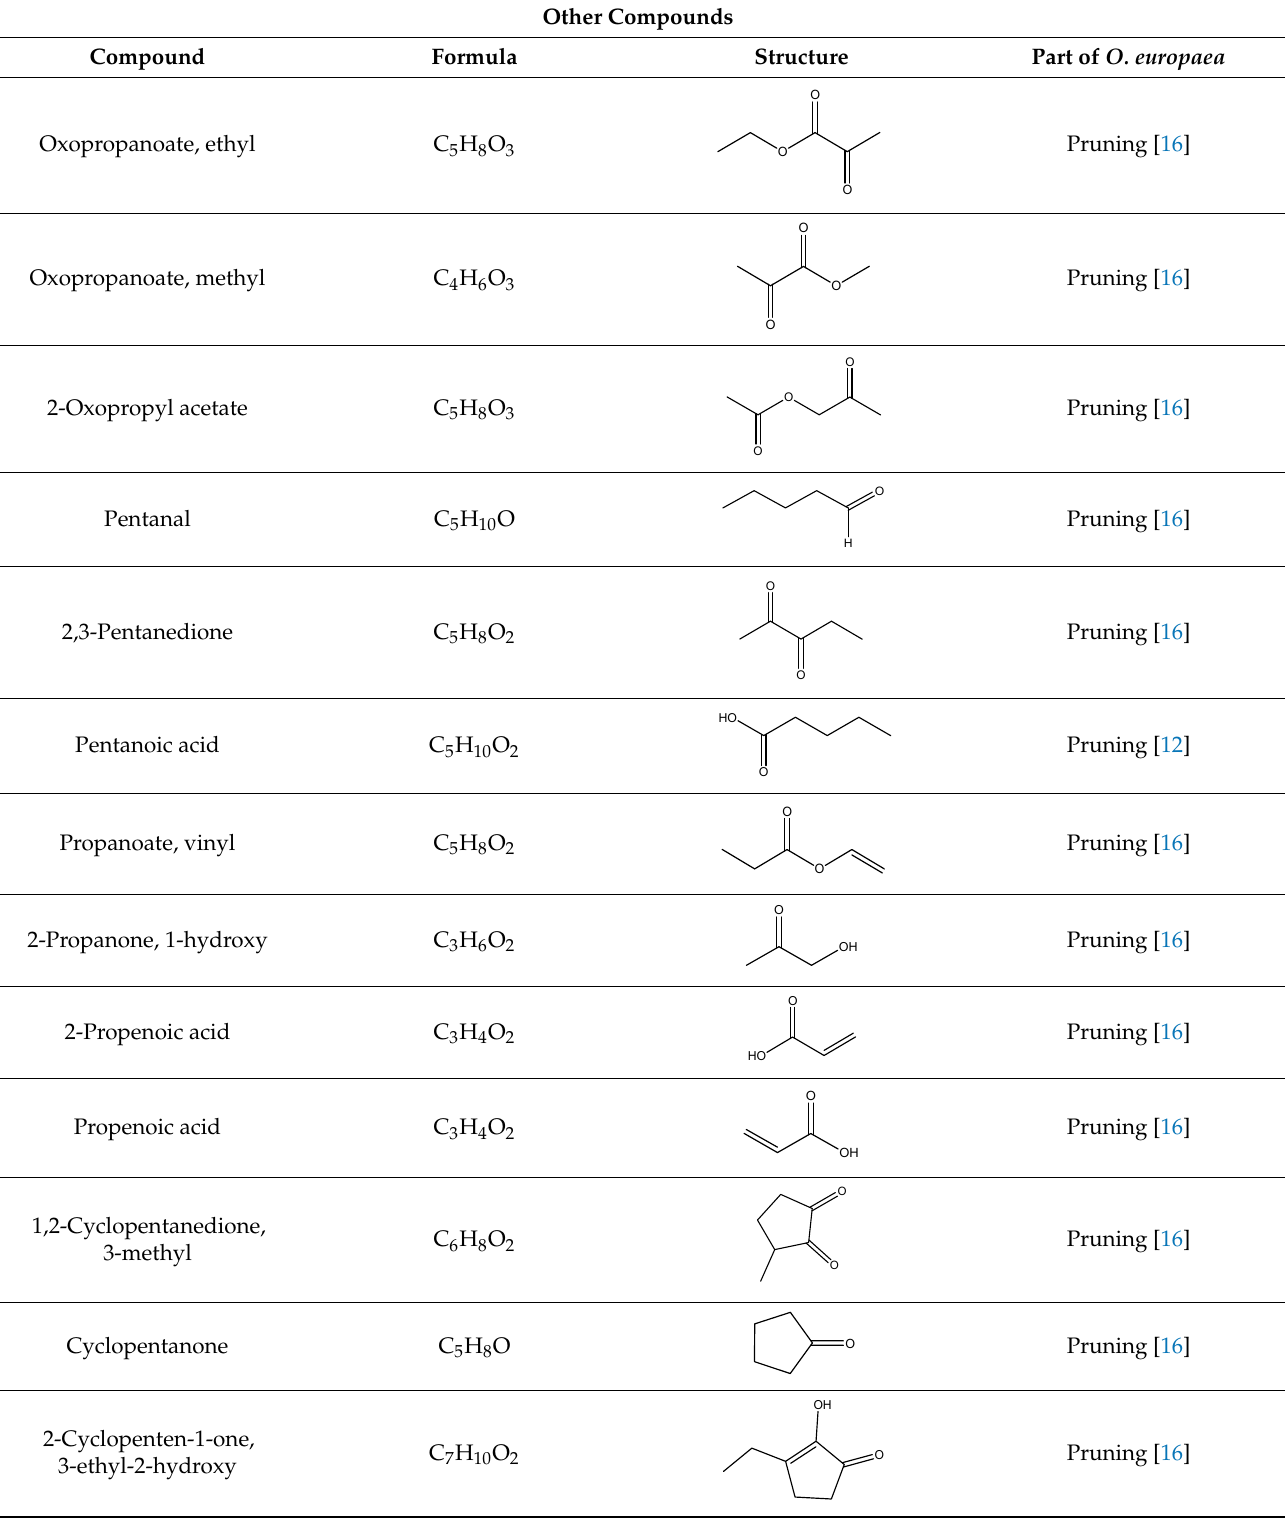
Table 1. Cont. Other Compounds Compound Formula Structure Part of O.